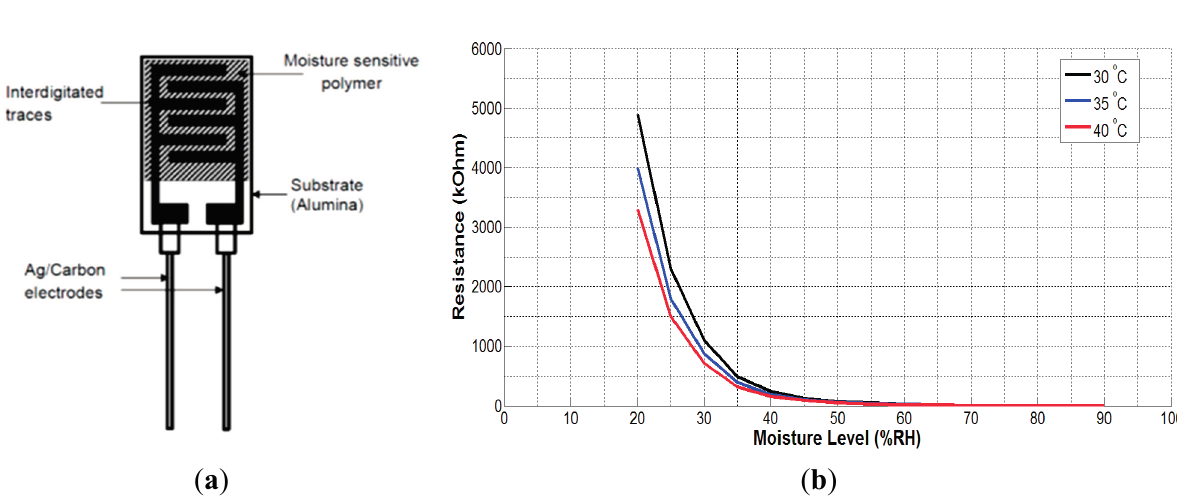
Figure 3. ( a ) Composition of the HCZ-D5 moisture sensor; ( b ) plot of sensor’s